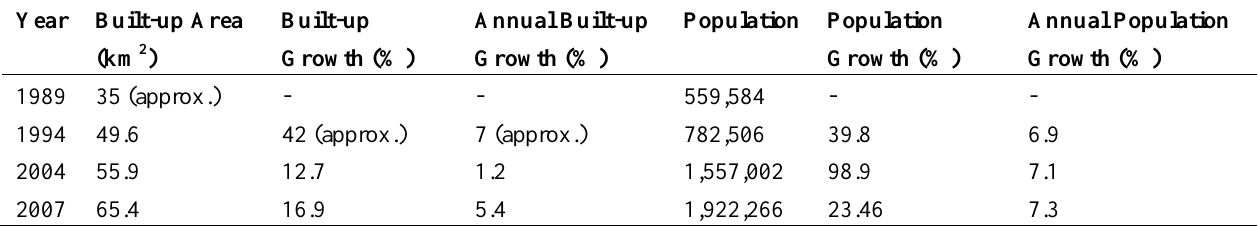
Table 3. Summary statistics of built-up and population growth for Sana’a. The baseline year is 1989. The built-up area of 1989 and built-up growth between 1989 and 1994 are approximated. Due to a different method for computing the urban areas, values cannot be compared directly.